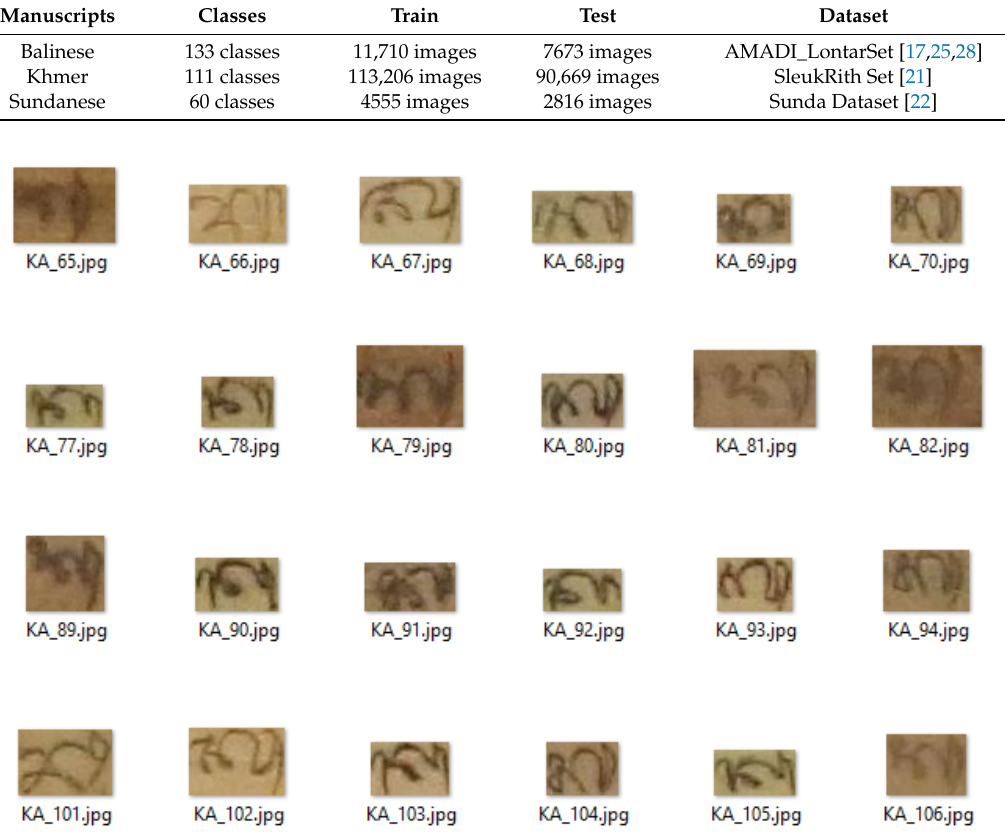
Table 3. Palm leaf manuscript datasets for isolated character/glyph recognition task.